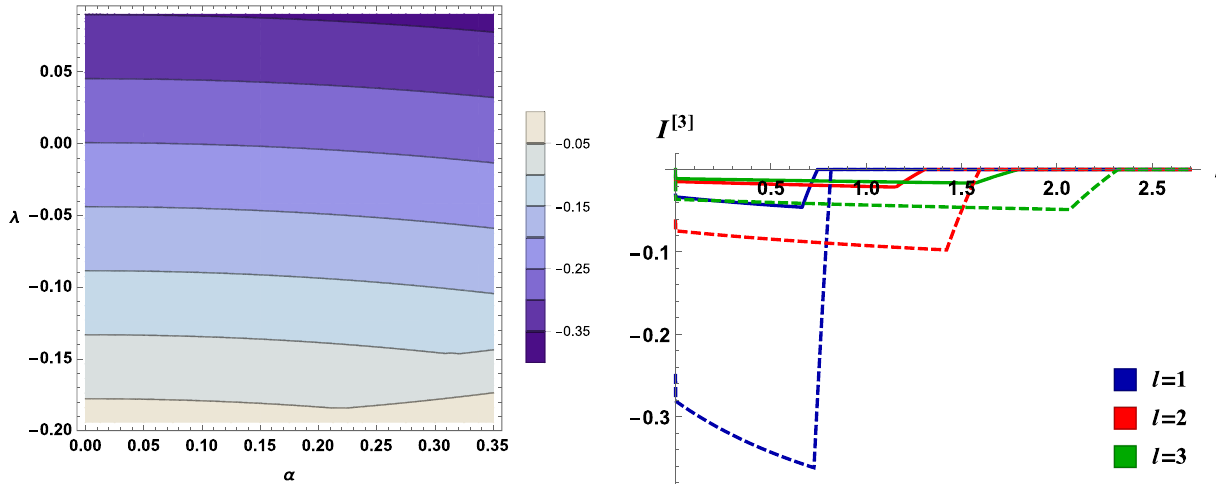
Fig. 5 Left plot: contour plot of tripartite information for (cid:3) = 1 and h = 0 . 7. Right plot: tripartite information for α = 0 . 3, λ = − 0 . 194 (solid curves) and λ = 0 . 09 (dashed curves). In all ranges that we have considered I [ 3 ] <